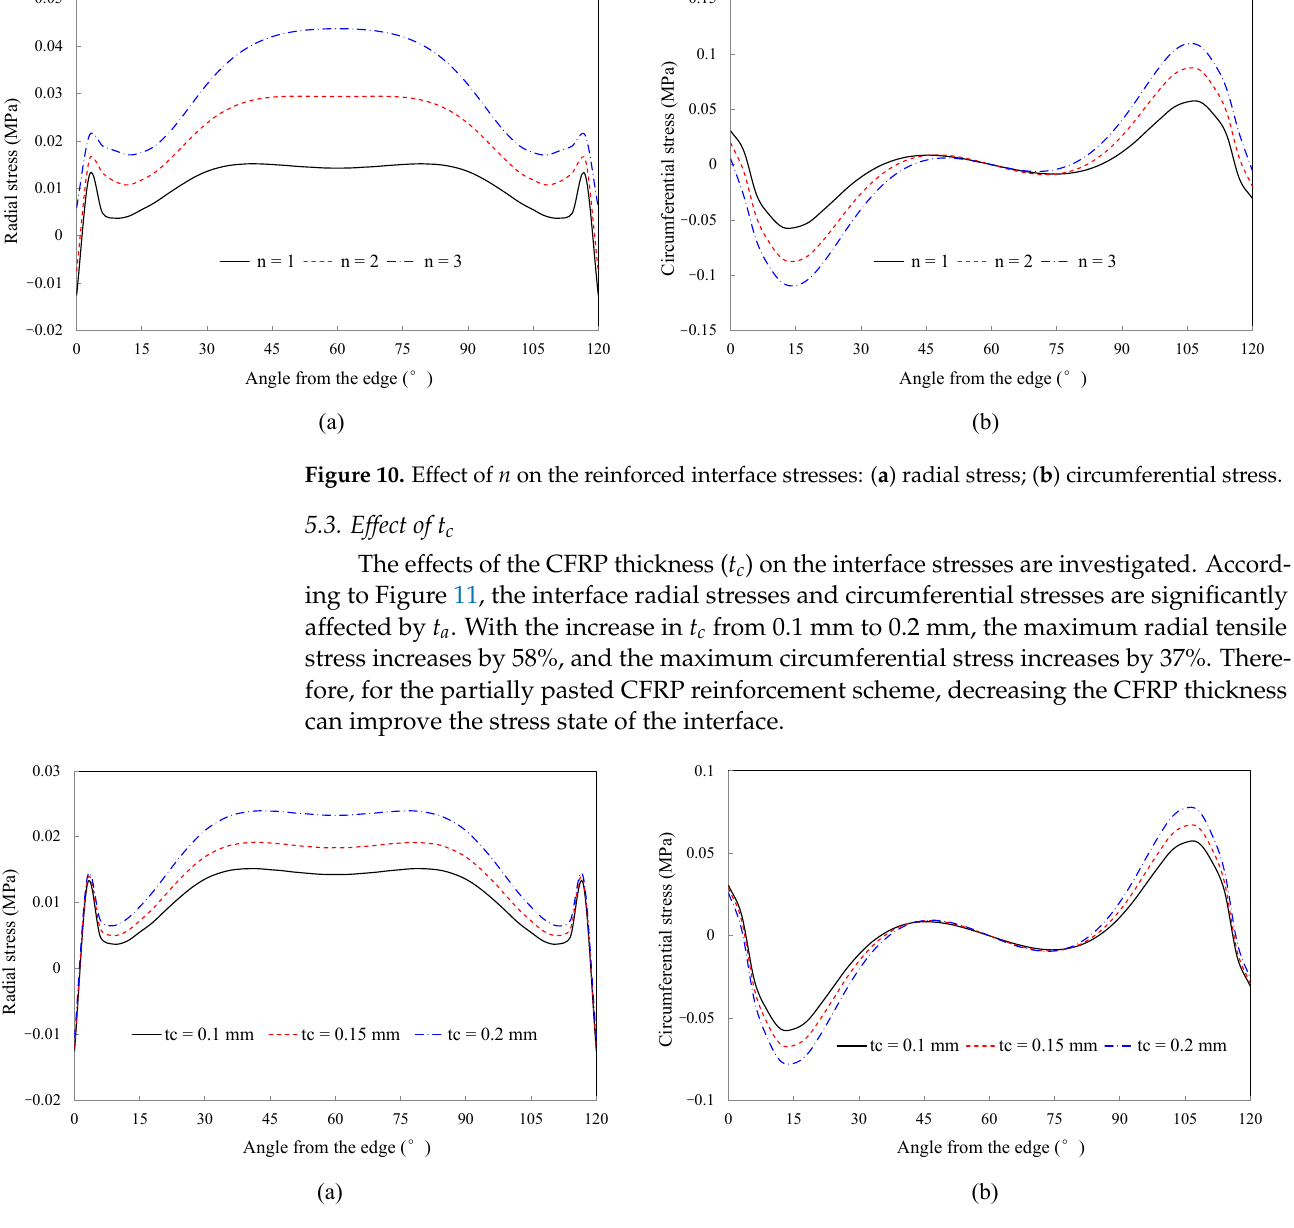
Figure 11. Effect of t c on the reinforced interface stresses: ( a ) radial stress; ( b ) circumferential stress.